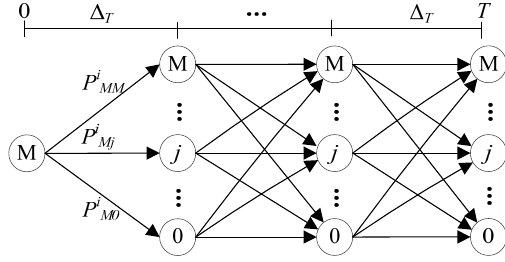
Figure 5. Different states of a component i during the time period T.